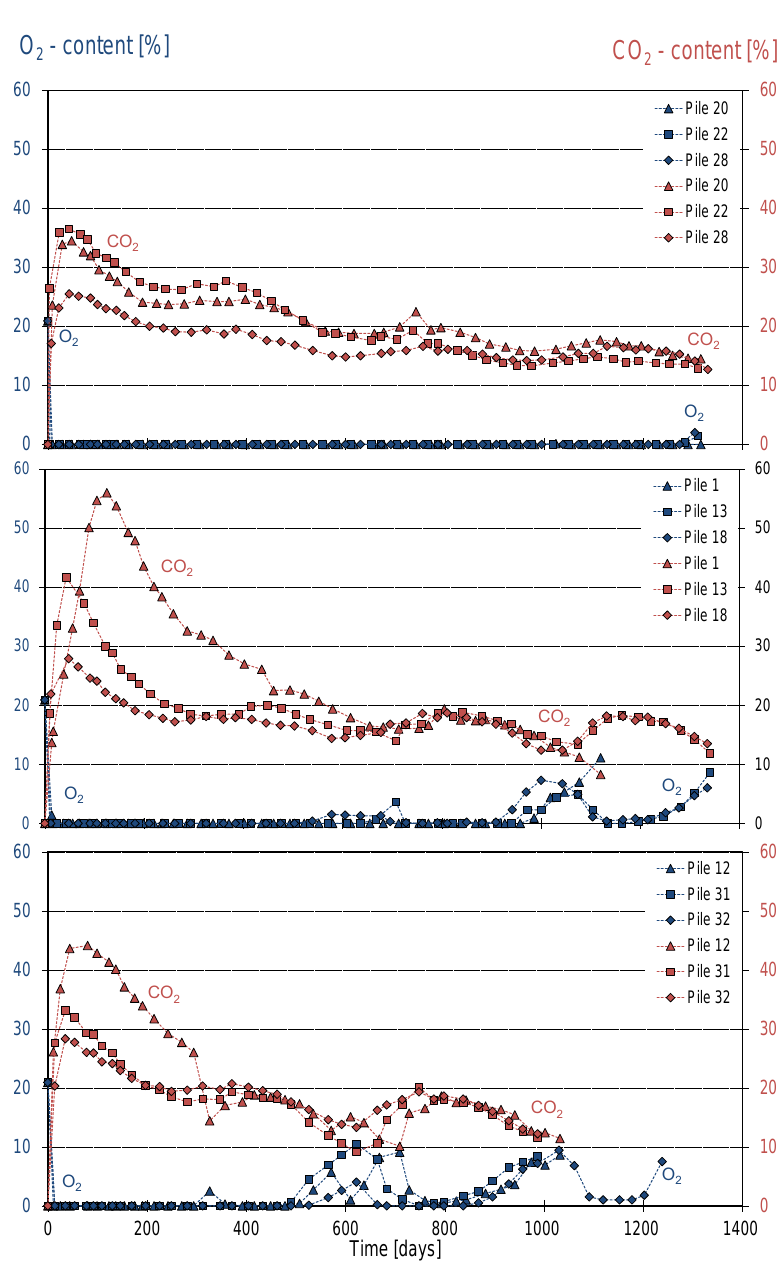
Figure 5. Pile interior atmosphere over the course of time during storage for three categories: (1) consistently unfavorable conditions for fungal growth and wood degradation; (2) moderate conditions; and (3) favorable conditions for fungal decay after less than two years of storage. The activity of both the cambium of the trees and the wood ‐ destroying microorgan ‐ isms is subject to seasonal fluctuations and is primarily dependent on respective